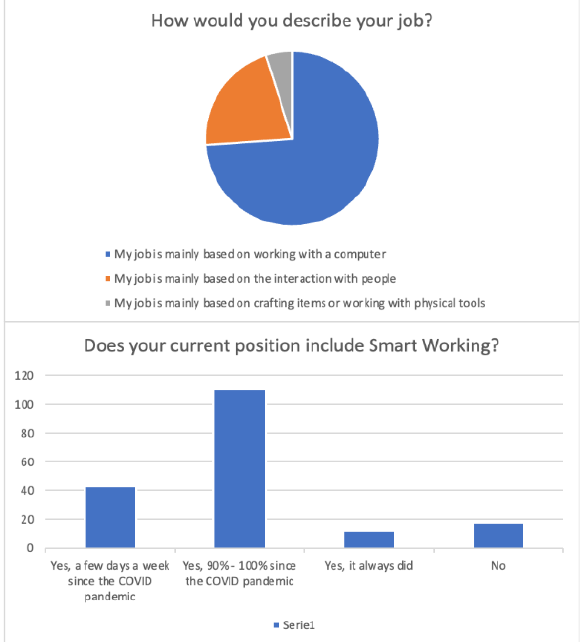
Fig 1 . People we interviewed are mostly high-educated, less than 30 years-old. After the pandemic situation, they usually moved working (partial or full) remotely. Just few of them ( 40 ) continued go to work 2 - 3 days a